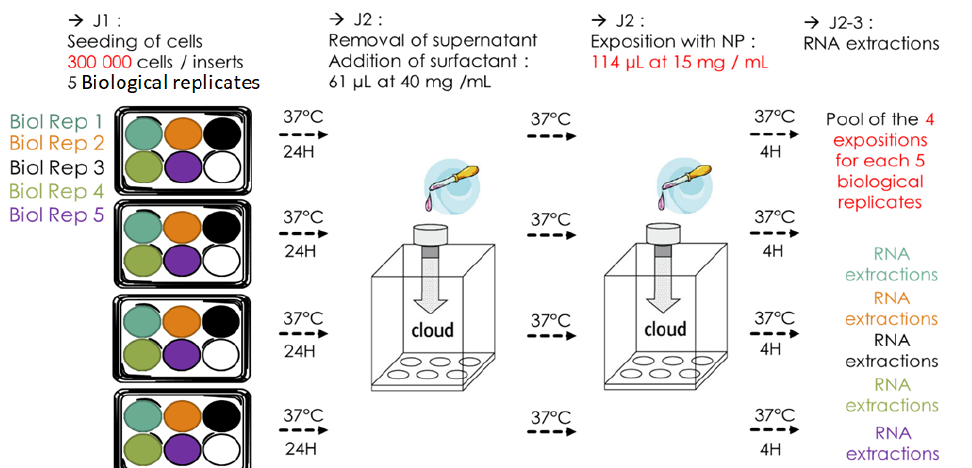
Figure 5. Current exposure protocol. For each 5 biological replicates (BR), NR8383 were seeded in 4 wells, in Transwell ® inserts, distributed in 4 6-well plates. The next day, for all 6-well plates, the inserts containing the cells were exposed (representing one technical replicate (TR) of each BR), by nebulization, first to 61 µL of whole porcine surfactant at 40 mg/mL, and then to 57 µL of TiO 2 NP at 30 mg/mL. After exposures, the Transwell ® inserts containing the cells was kept at 37 °C for 4 h, and the 4 wells (TR) of each BR were pooled for RNA